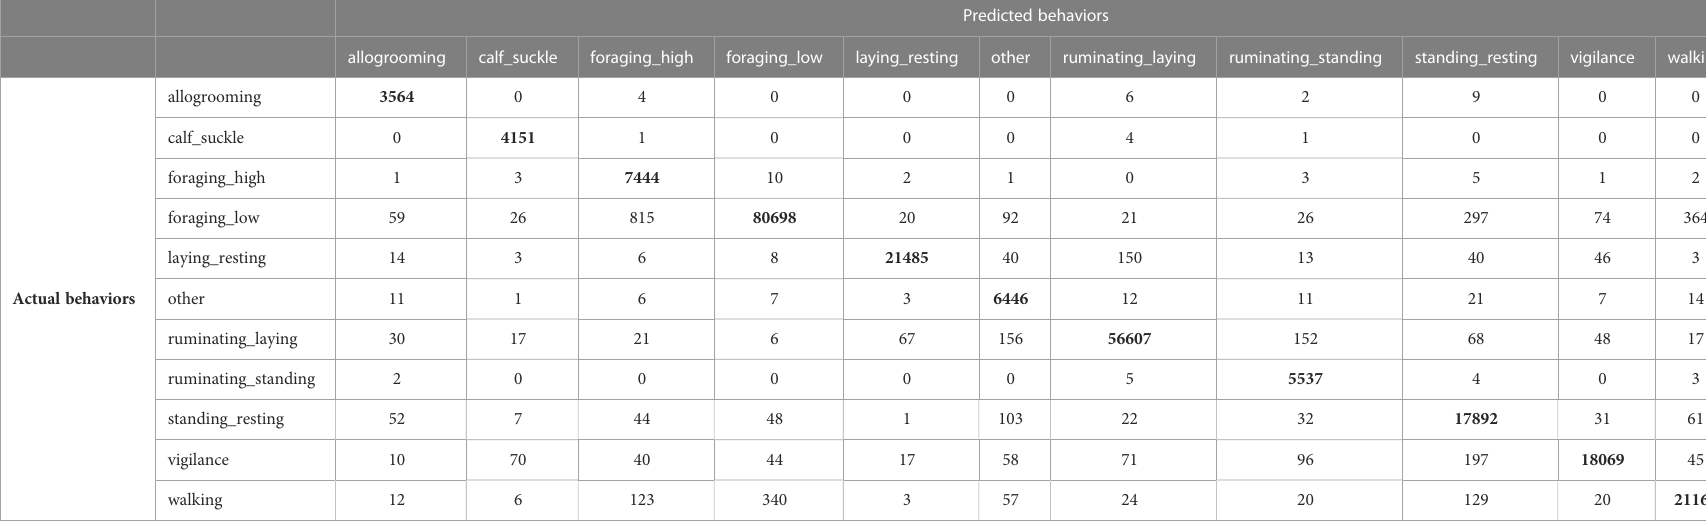
TABLE 3 Confusion matrix for the orientation dependent features without collar correction with 20 seconds running